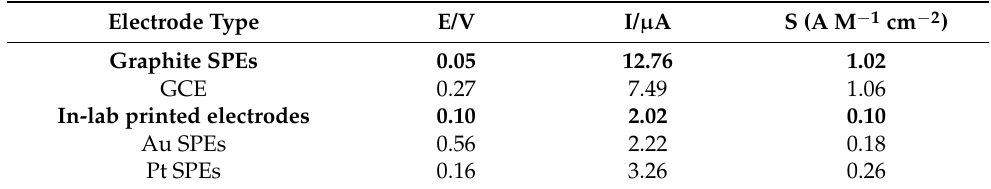
Table 1. Analytical parameters regarding the electrochemical oxidation of Ent on different electrode materials